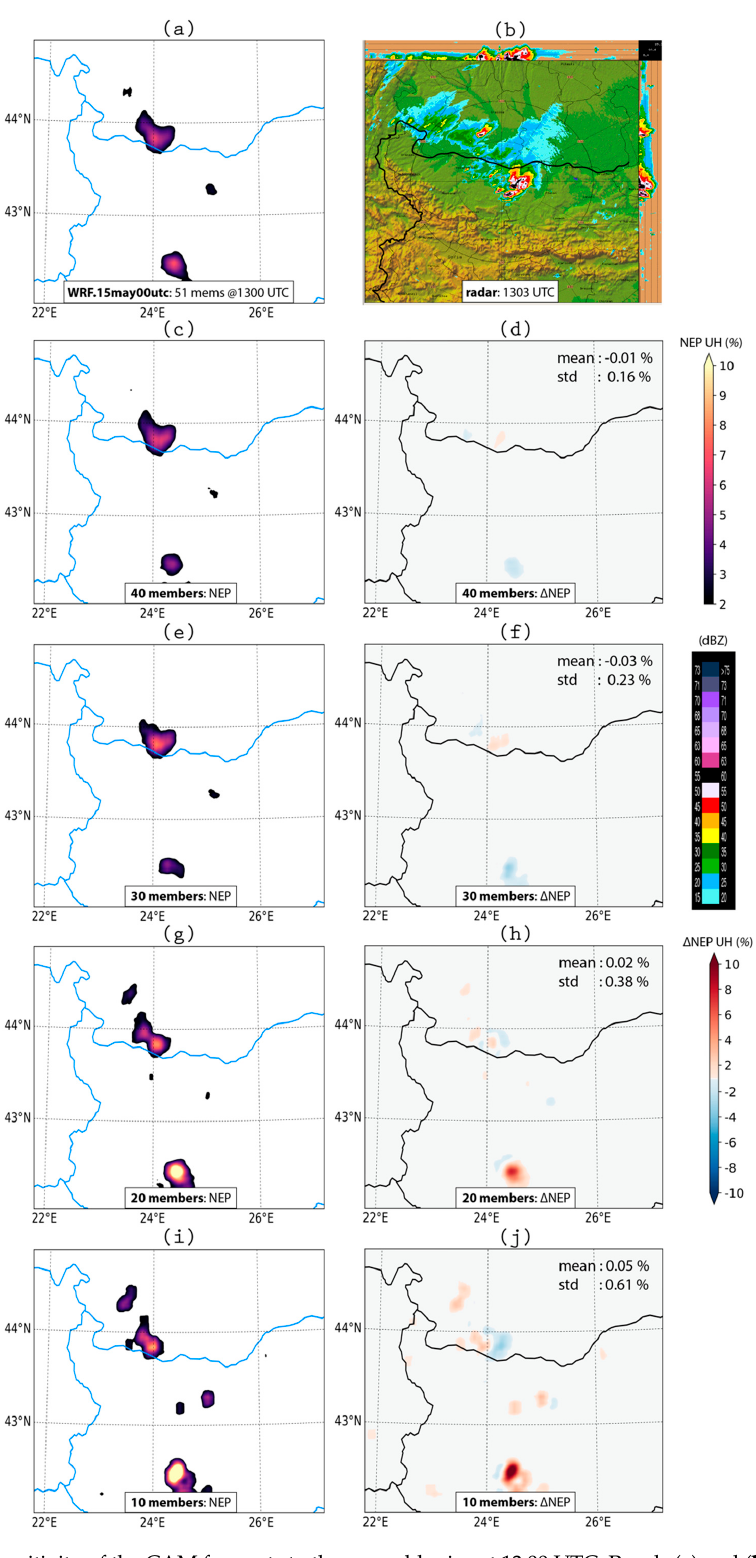
Figure 19. Sensitivity of the CAM forecasts to the ensemble size at 13:00 UTC. Panels ( a ) and ( b ) refer to the NEP UH field from the full 51-member ensemble and the corresponding radar observations. The remaining figures on the left display NEP fields from the worst performing ensemble subset with ( c ) 40, ( e ) 30, ( g ) 20 and ( i ) 10 members, while the remaining figures on the right - differences in the NEP UH fields between the full 51-member ensemble and the worst performing ensemble subset with ( d ) 40, ( f ) 30, ( h ) 20 and ( j ) 10 members. Note that the mean and standard deviation of these difference fields are displayed in the upper right corner of the